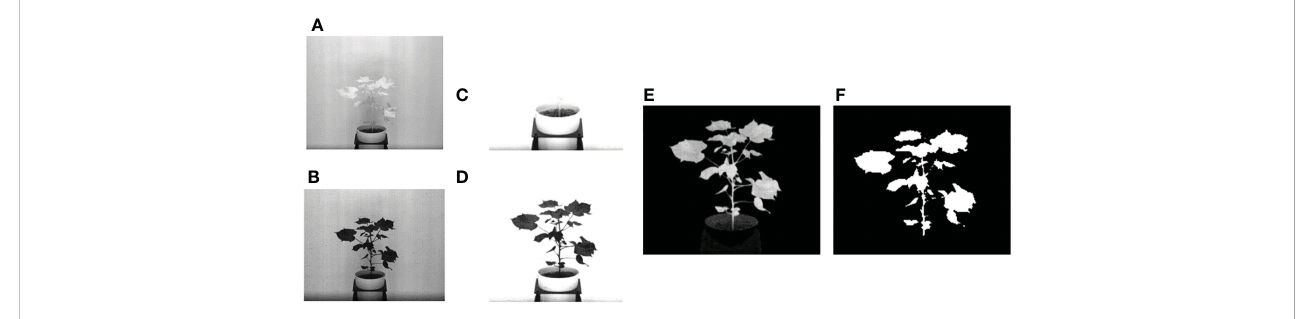
FIGURE 7 Illustration of spectral band difference based segmentation: (A, B) - hyperspectral images of a cotton plant at wavelengths 770 nm and 680 nm, respectively; (C, D) - corresponding enhanced images; (E) image obtained after subtracting (C) from (D) ; and (F) binary image.